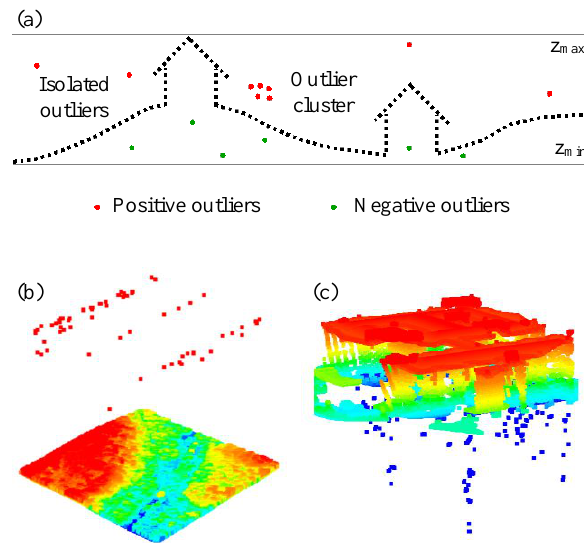
Figure 1. (a) ALS outlier taxonomy. Examples of datasets with (b) positive and (c) negative